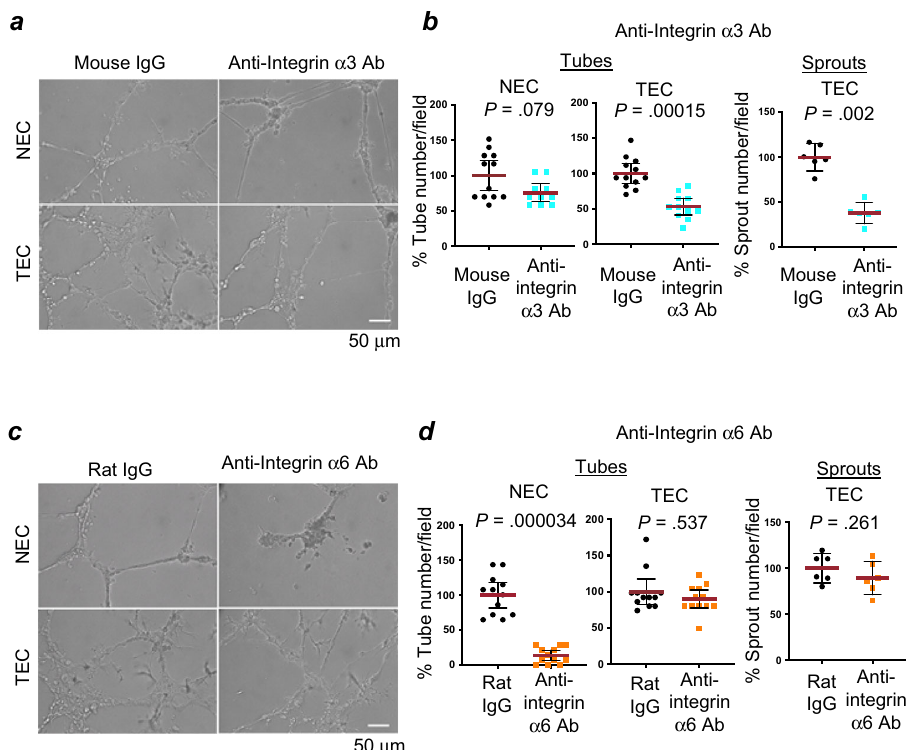
Fig. 3 A function blocking antibody directed towards integrin α 3 β 1 signi fi cantly reduces tube and sprout formation by TECs. a , c NECs (623) or TECs (isolate ccf2445) were incubated with function blocking antibodies towards the integrin α 3 subunit or integrin α 6 subunit, or control IgG (mouse IgG or rat IgG) at 5 µ g/ml when plated on growth factor-reduced Matrigel in M199 medium + 10% FBS for 43 h. Representative images are shown. b , d The mean numbers of tubes or sprouts in the mouse IgG or rat IgG-treated group are represented as 100%. Dot plots show % mean of the numbers of tubes or sprouts (red lines) and the 95% con fi dence interval (black lines). Statistical analyses: two-sided Wilcoxon-rank-sum tests. Independent experiments were performed at least two times with similar results. n denotes the number of different fi elds. b The n for tubes: NECs, n = 12 for mouse IgG and n = 10 for anti-integrin α 3; and TECs, n = 12 for mouse IgG and n = 11 for anti-integrin α 3. The n for sprouts: TECs, n = 6 for mouse IgG and n = 6 for anti-integrin α 3. d The n for tubes: NECs, n = 12 for rat IgG and n = 12 for anti-integrin α 6; and TECs, n = 12 for rat IgG and n = 12 for anti-integrin α 6. The n for sprouts: TECs, n = 6 for rat IgG and n = 6 for anti-integrin α 6. Source data are provided as a source data fi